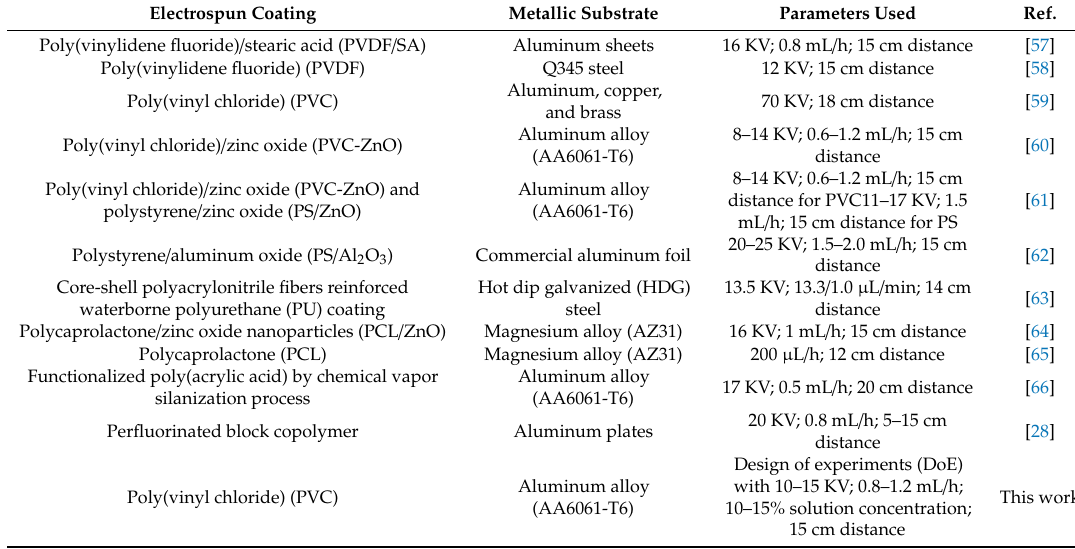
Table 3. Summary of di ff erent electrospun coatings with a hydrophobic or even superhydrophobic behavior deposited onto the metallic substrates with their corresponding deposition